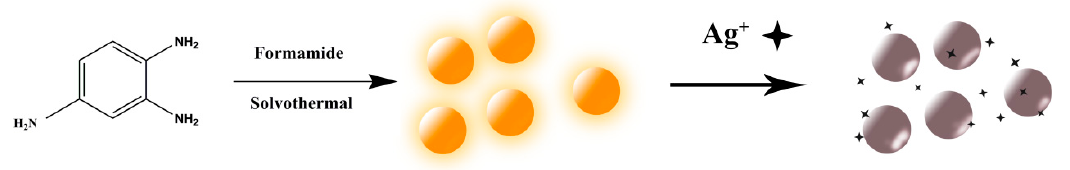
Figure 1. Mechanism of silver ions detection by nitrogen-doped carbon quantum dots (N-CQDs).